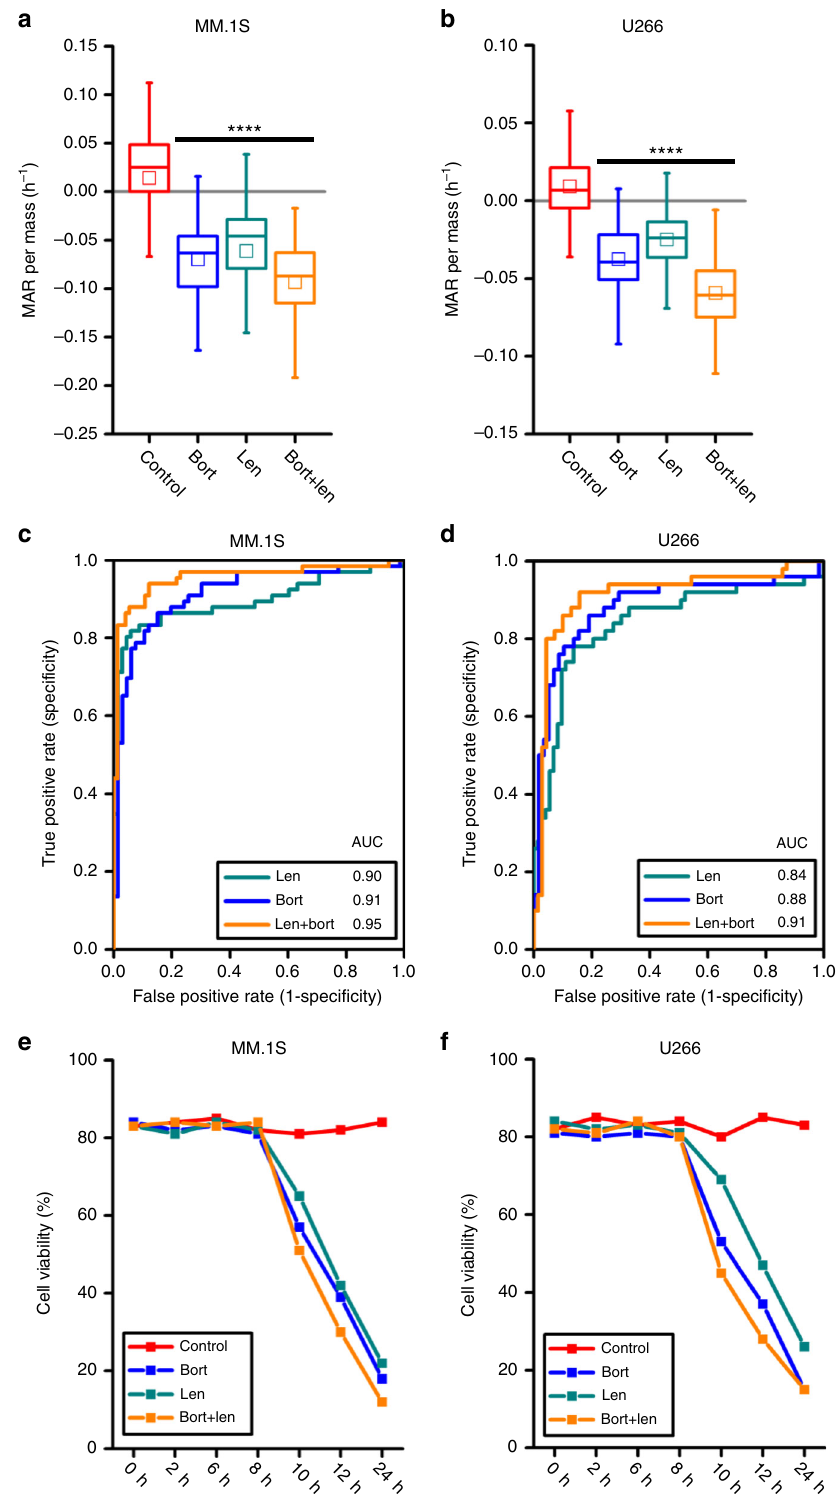
Fig. 4 MAR de fi nes drug sensitivity of human multiple myeloma MM.1S and U266 cells to lenalidomide therapy and its combination with bortezomib. a , b MAR per mass distributions of MM.1S and U266 cells treated in 5 nM bortezomib, 3 µ M lenalidomide and their combinations for 3 h. MAR per mass of both cell lines reduces upon exposure to both drug treatment. Boxes represent the inter-quartile range and white squares the average of all measurements. p values were calculated using Welch ’ s t -test, comparing treated cells to the control (cells seeded only in culture media), and were Bonferroni corrected **** p < 10 − 4 in highlighted segments. For MM.1S cells; p (control vs. bort.) = 1.7 × 10 − 9 , p (control vs. len.) = 1.1 × 10 − 8 , p (control vs. bort. + len.) = 2.8 × 10 − 16 and for U266 cells; p (control vs. bort.) = 9.9 × 10 − 11 , p (control vs. len.) = 5.9 × 10 − 8 , p (control vs. bort. + len.) = 4.1 × 10 − 15 . From left to right, number of cells in MAR measurement n (MM.1S) = 66, 66, 68, 74 and n(U266) = 50, 58, 73, 70. c , d ROC curves of control and treatment (bort, len, bort + len) data for MM.1S and U266 cells. e , f Cell viability analysis for MM.1S and U266 cells under different drug